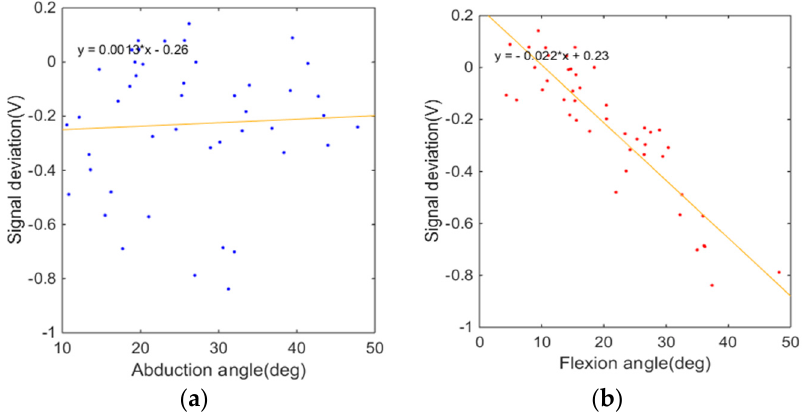
Figure 6. Representative CMC-joint flexion sensor response with the sensor in the optimal location. p x , y , φ q “ p 0.5,0.333, ´ 39 ˝ q for Subject 3: ( a ) sensor response with respect to CMC-joint abduction angle; ( b ) sensor response with respect to CMC-joint flexion angle.